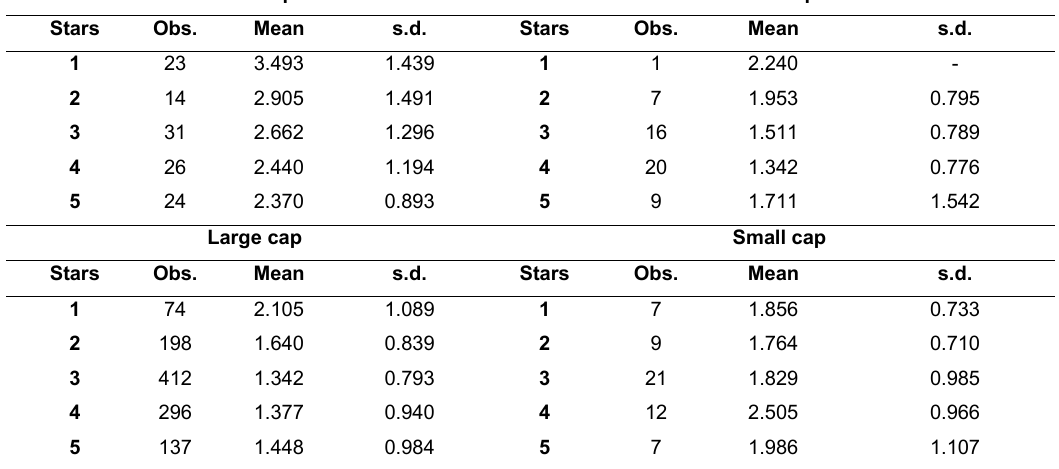
Table 1. Number of observations by category, Rating and level of